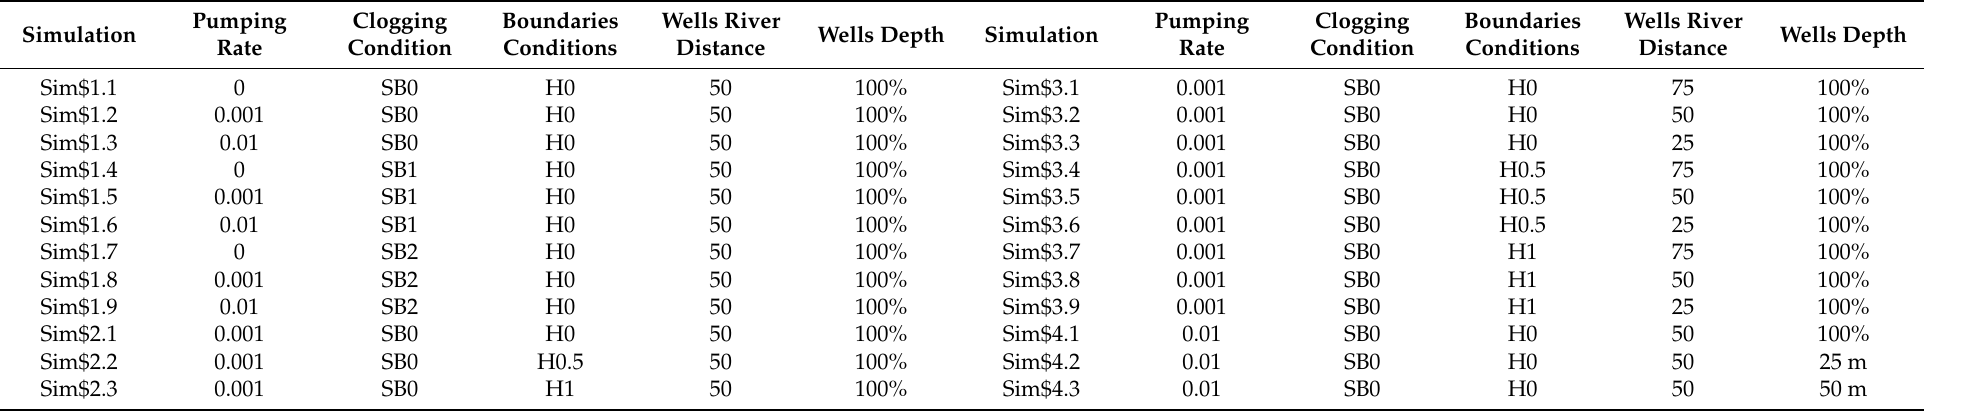
Table 2. Boundary conditions and parameters for the different simulations. For the simulation sets Sim$1, Sim$2, Sim$3, the Aspect Ratio Ar was varied from 0.05 to 1, leading to 400 simulations. For Sim$4, Ar is fixed to 1. The boundary conditions H0, H0.5 and H1 correspond to a right-side boundary prescribed at 16.5 m, 16 m, 15.5 m, respectively, while the left boundary condition is maintained at 16.5